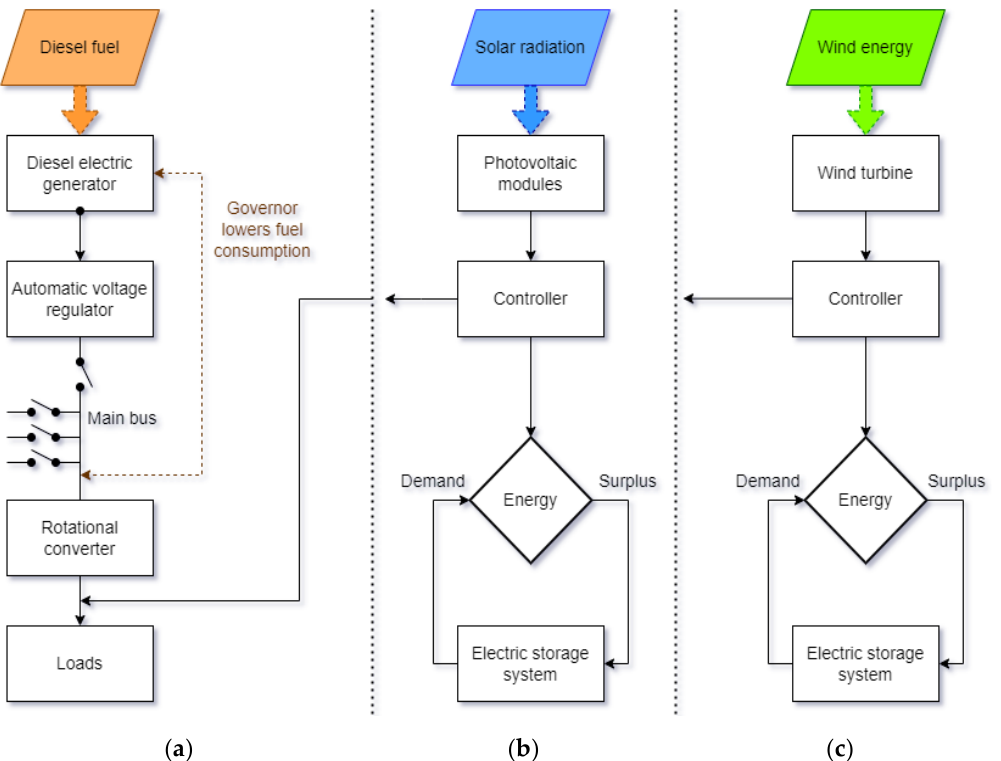
Figure 4. Hybrid energy system scheme; ( a ) schematic diagram of the existing ship ’ s power system, ( b ) implementation of solar energy, and ( c ) implementation of wind energy.